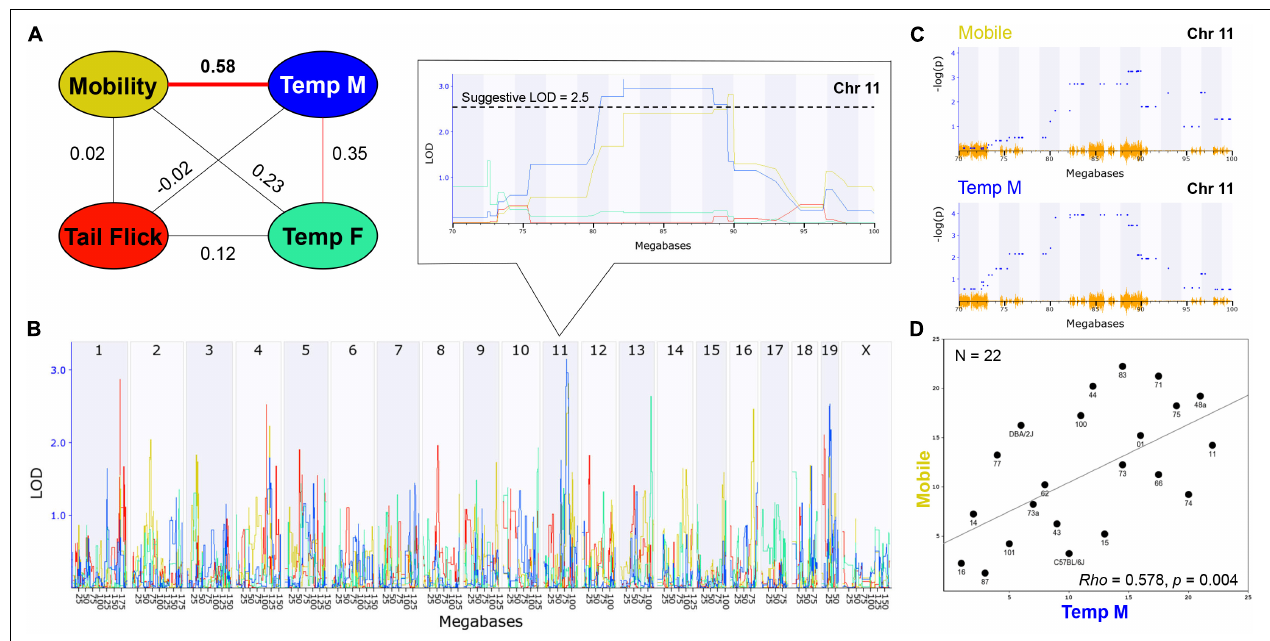
FIGURE 3 | THC Initial Response Trait Correlations and Genetic Co-Regulation. (A) Trait correlation network constructed after calculating Pearson’s correlation on ranked trait values to generate Spearman’s rank order correlation coefficient (Rho or P). The hypothermia trait was split by sex due to a condition-by-sex interaction effect on body temperature change in response to THC. Changes in time mobile in the open field and body temperature in males following a single THC (10 mg/kg) exposure are significantly ( p < 0.01) correlated. Weak (not significant) correlations are also observed between mobility and hypothermia in females following a single THC exposure and between changes in male and female hypothermia in response to THC. (B) Genetic regulation of THC initial response traits is observed, albeit at a suggestive level with no traits passing the threshold for genome-wide significance ( p < 0.05). Interval maps for each trait shown as a different line color corresponding to the correlation network in (A) . The strength of association (LOD) on the y -axis is plotted for each trait across the genome (megabase position on each chromosome or Chr) on the x -axis. Change in mobility and male body temperature are regulated by the same suggestive locus on Chr 11 (zoomed region in boxed area). (C) Use of an alternative linear mixed-model QTL mapping method (GEMMA, see section “Materials and Methods”) resulted in replication of genetic co-regulation of initial motor and hypothermia THC response traits from the same Chr 11 interval. Strength of association or –log( P ) values ( y -axis) shown for each marker (blue dots) within the Chr 11 QTL interval for mobility and temperature (males) initial THC response traits. Mapping with linear mixed-models can account for population family structure or kinship within the BXD population that is not addressed using traditional interval mapping. SNP density plotted in orange on the x -axis. (D) Scatterplot describing the relationship between average change in time mobile in the open field in response to THC ( X -axis) and average change in male body temperature in response to THC ( Y -axis) for each BXD strain based on Spearman’s rank order correlation.